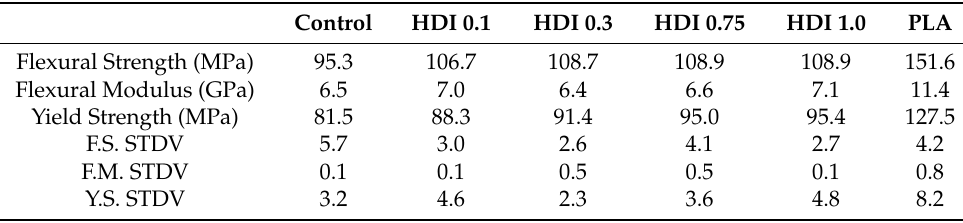
Table 4. Flexural properties (strength, modulus, and yield strength) of PLA/PBSeT based blends with various HDI